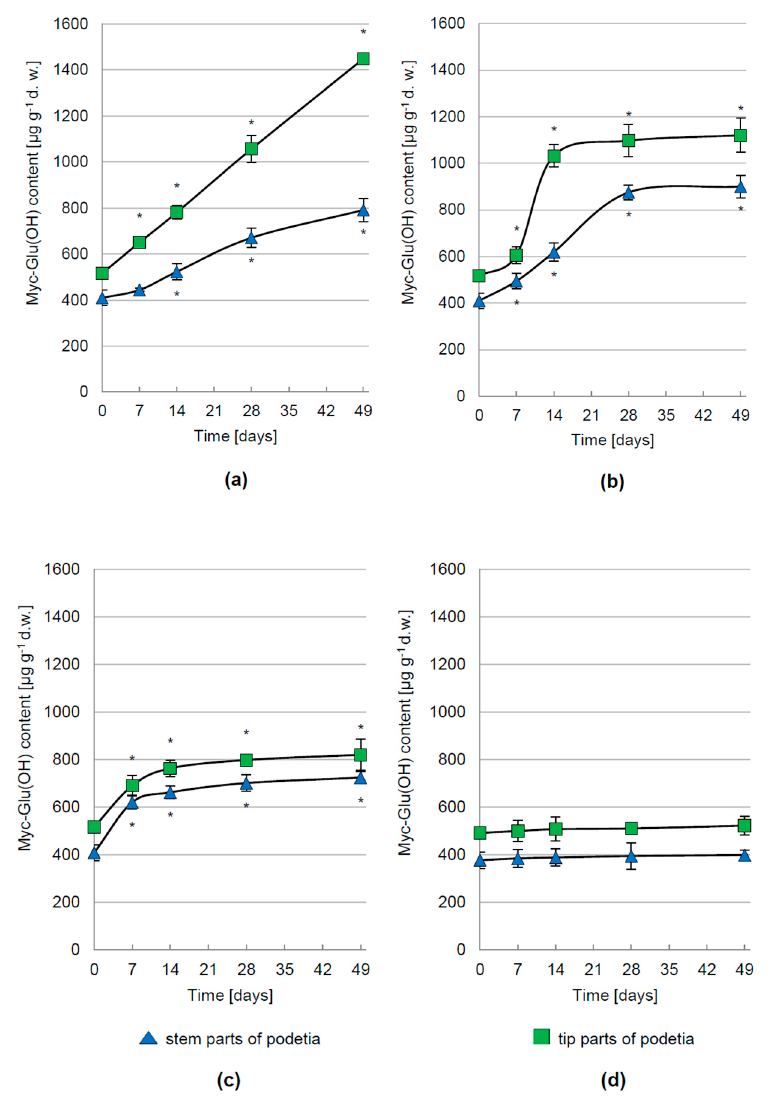
Figure 3. The concentration of Myc-Glu(OH) in C. arbuscula thalli exposed to PAR at intensity of: ( a ) 1000 µ mol m − 2 s − 1 ; ( b ) 1500 µ mol m − 2 s − 1 ; and ( c ) 2000 µ mol m − 2 s − 1 and ( d ) darkness conditions; n = 5 ± S.D.; * p < 0.05, d.w.—dry